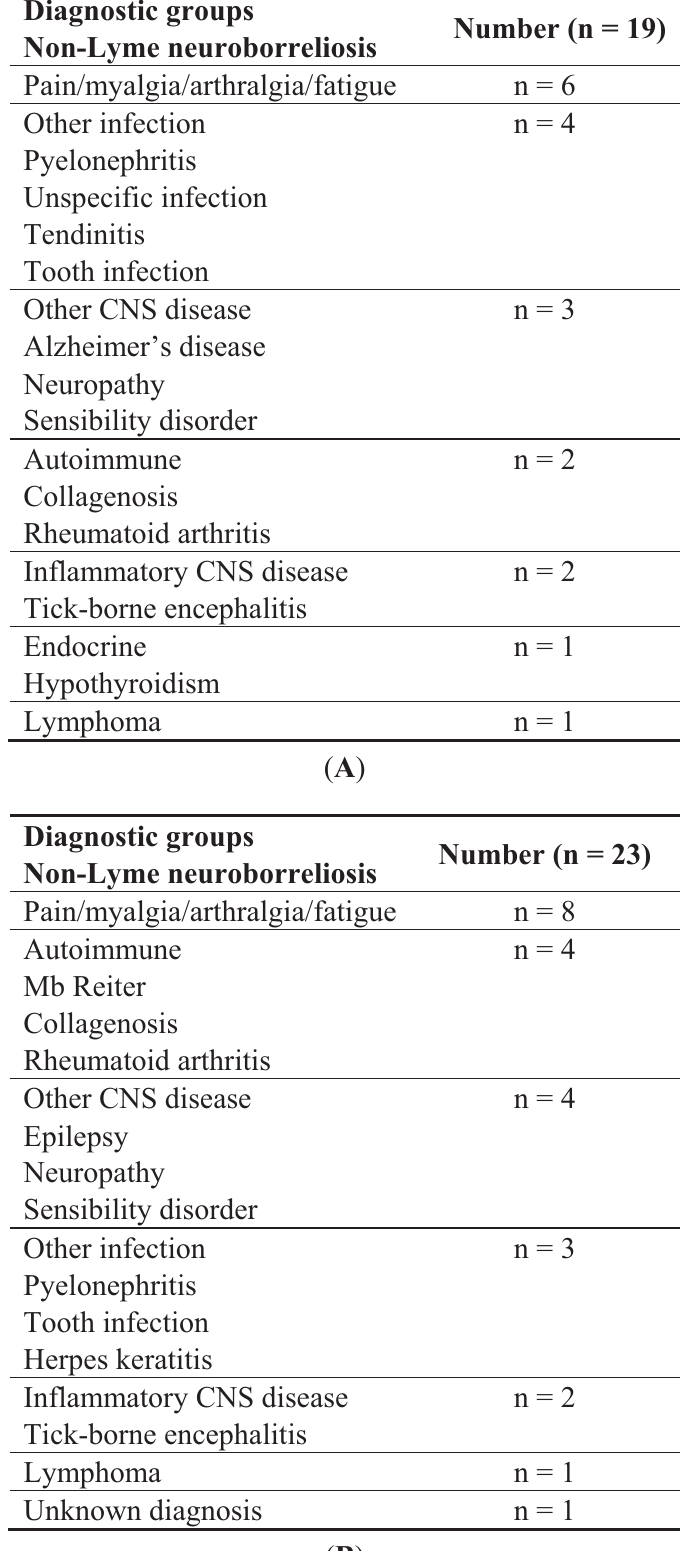
Table 2. ( A ) Borrelia- induced Non-Lyme neuroborreliosis patients that were positive in the ELISPOT ((cid:3)5 spots) assay in cerebrospinal fluid, classified into different diagnostic groups; ( B ) Non-Lyme neuroborreliosis patients with spontaneous secretion of 15 spots or more, classified into different diagnostic